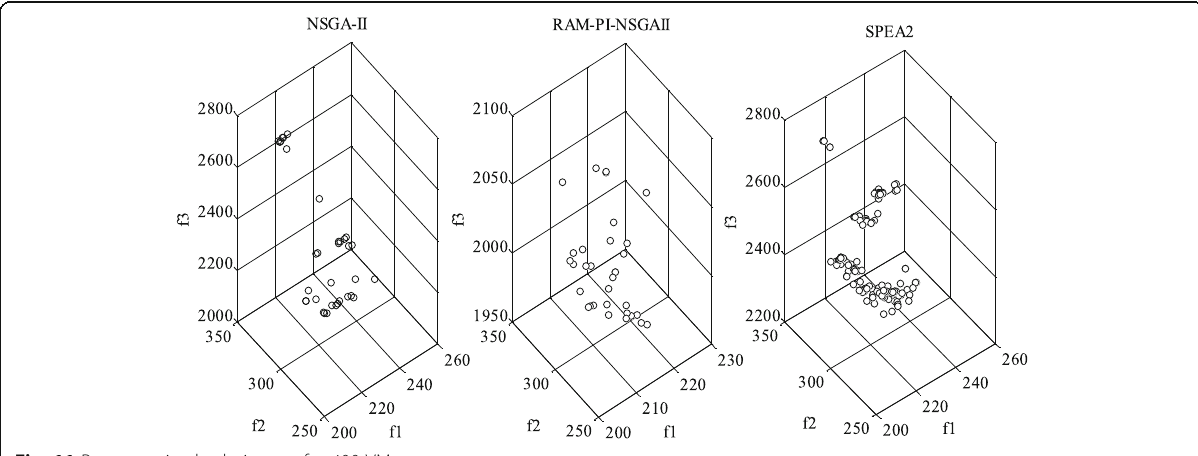
Fig. 11 Pareto optimal solution set for 400 VM